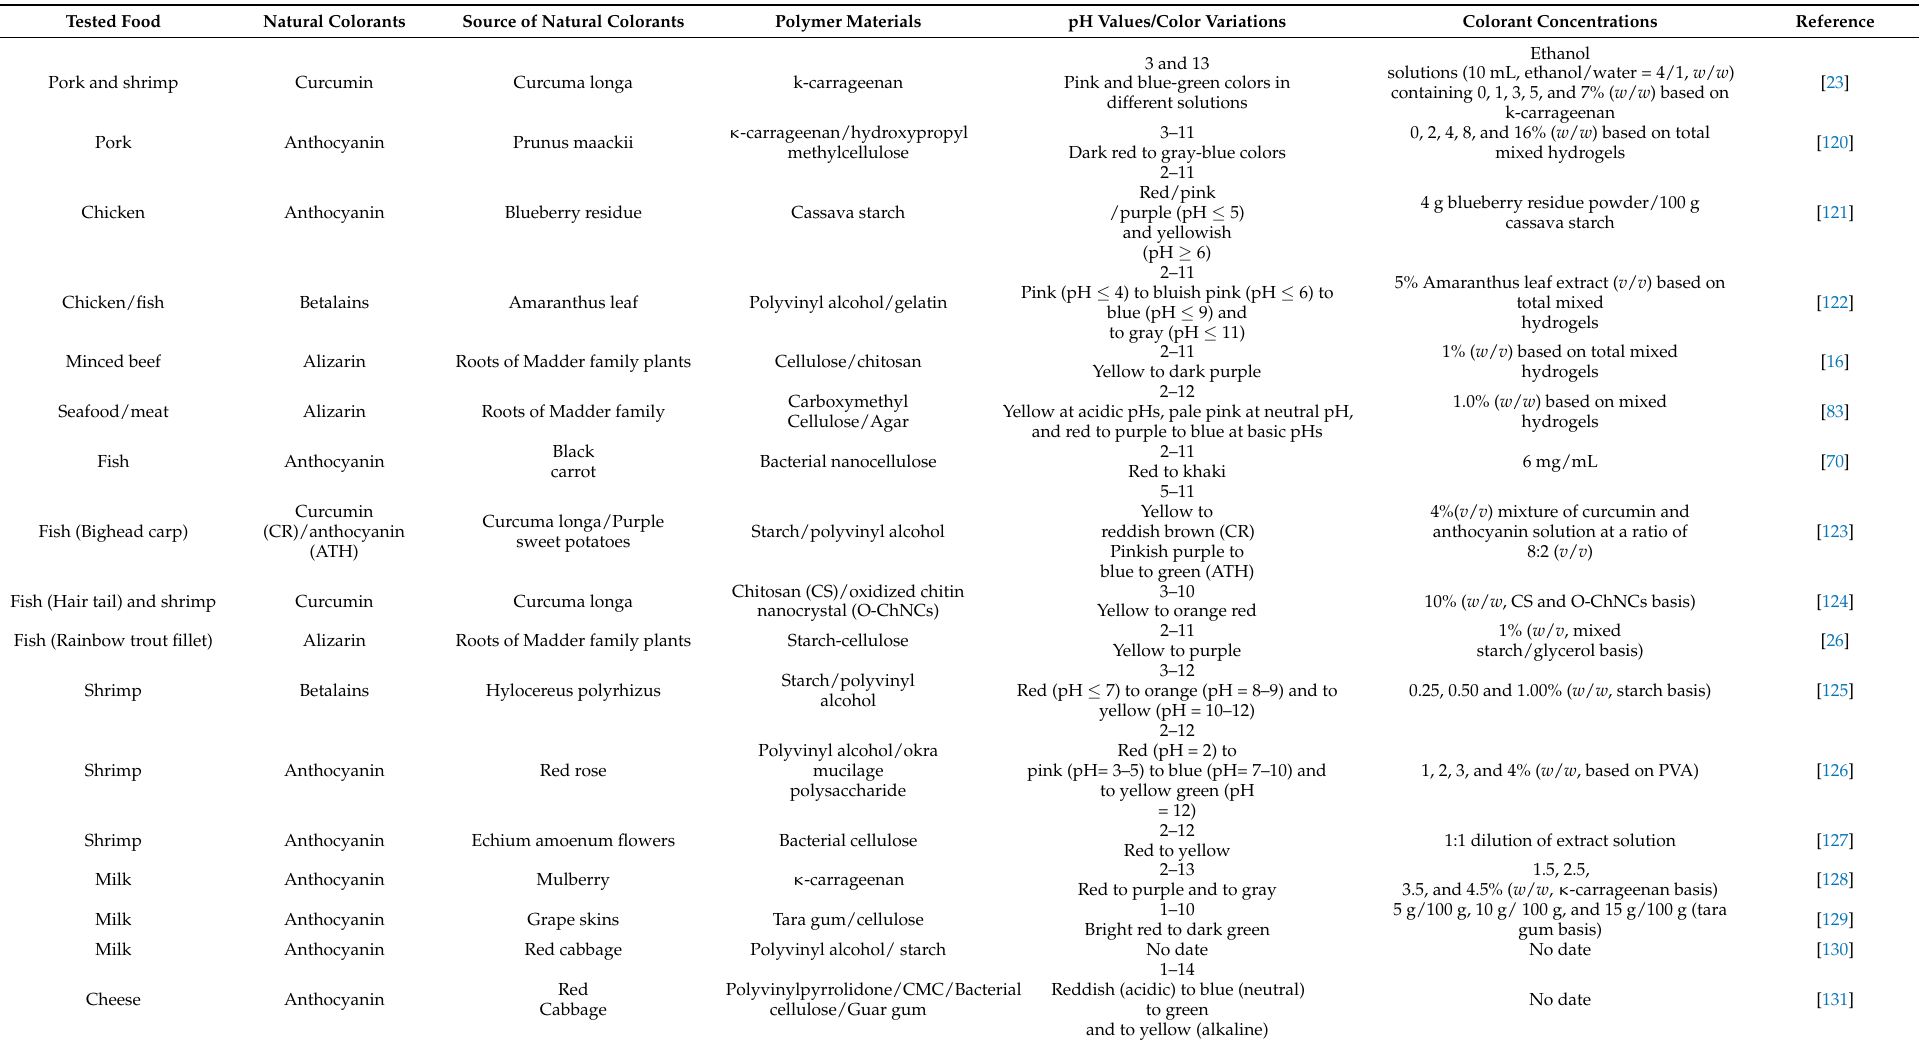
Table 2. Natural-colorants-based pH-responsive freshness indicators for monitoring freshness of food